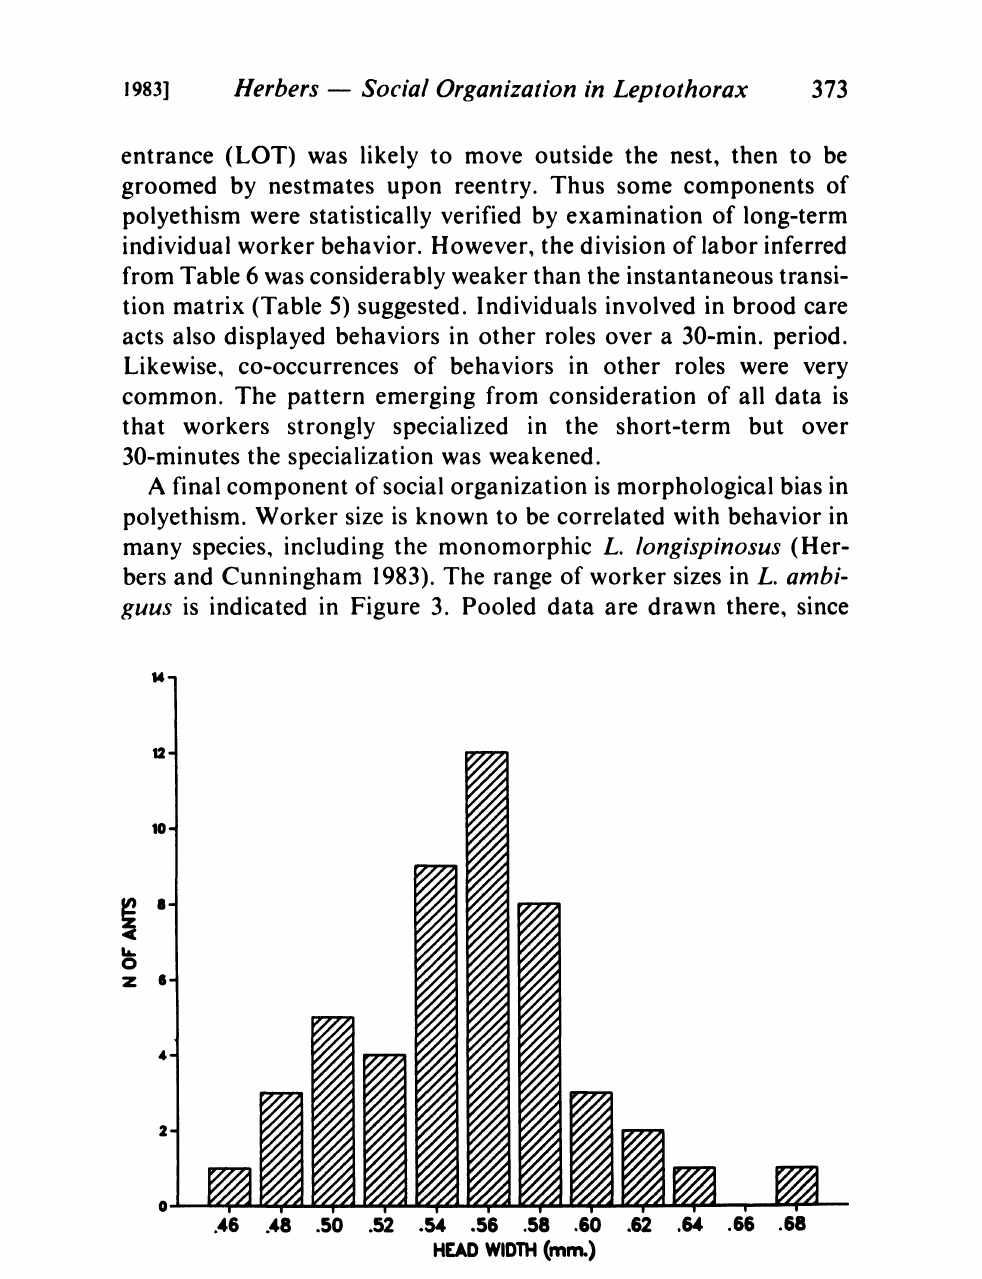
Figure 3. Morphological variation in L. ambiguus workers. Head width distribu- tion was normal, and the largest worker was less than 1.5 times that of the